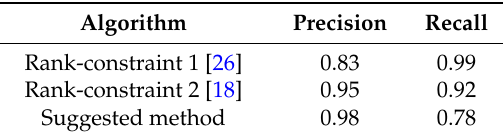
Figure 5. Car example with 200 consecutive frame sets. The rank-constraint models give better results in terms of recall ( left ), however, the precision of overall results is better with the suggested method ( right ) due to the additional filters. Table 1. Precision and recall comparison